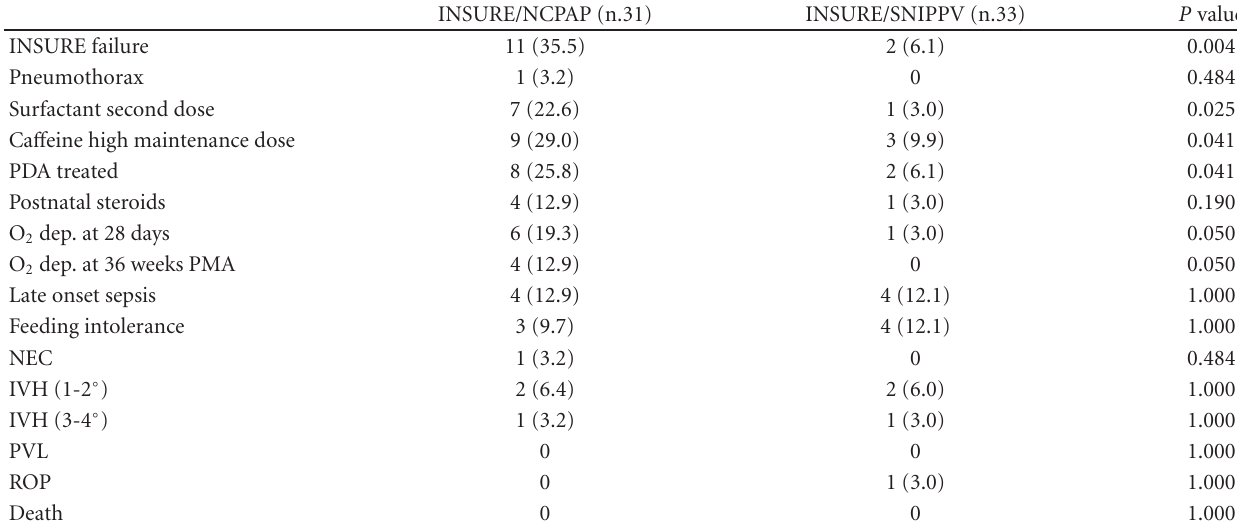
Table 2: Neonatal outcomes in the two study groups.